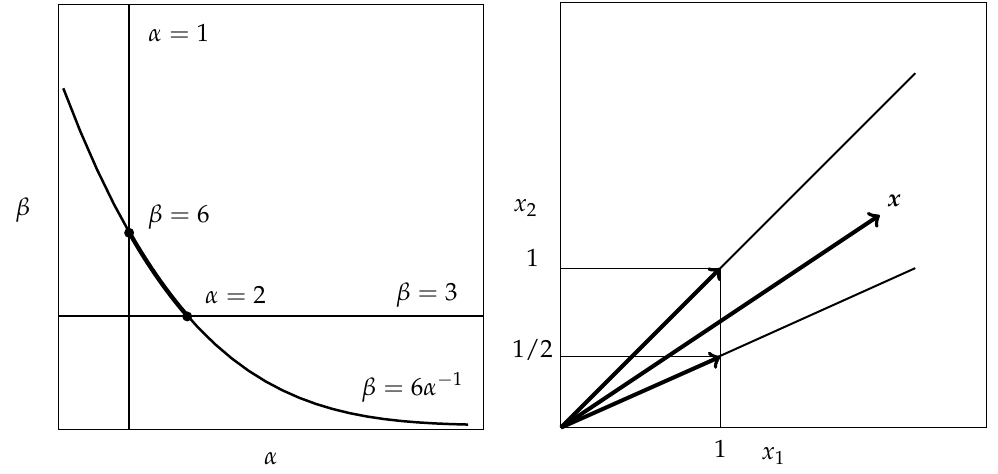
Figure 2. Pareto frontier ( left ) and Pareto-optimal solution ( right